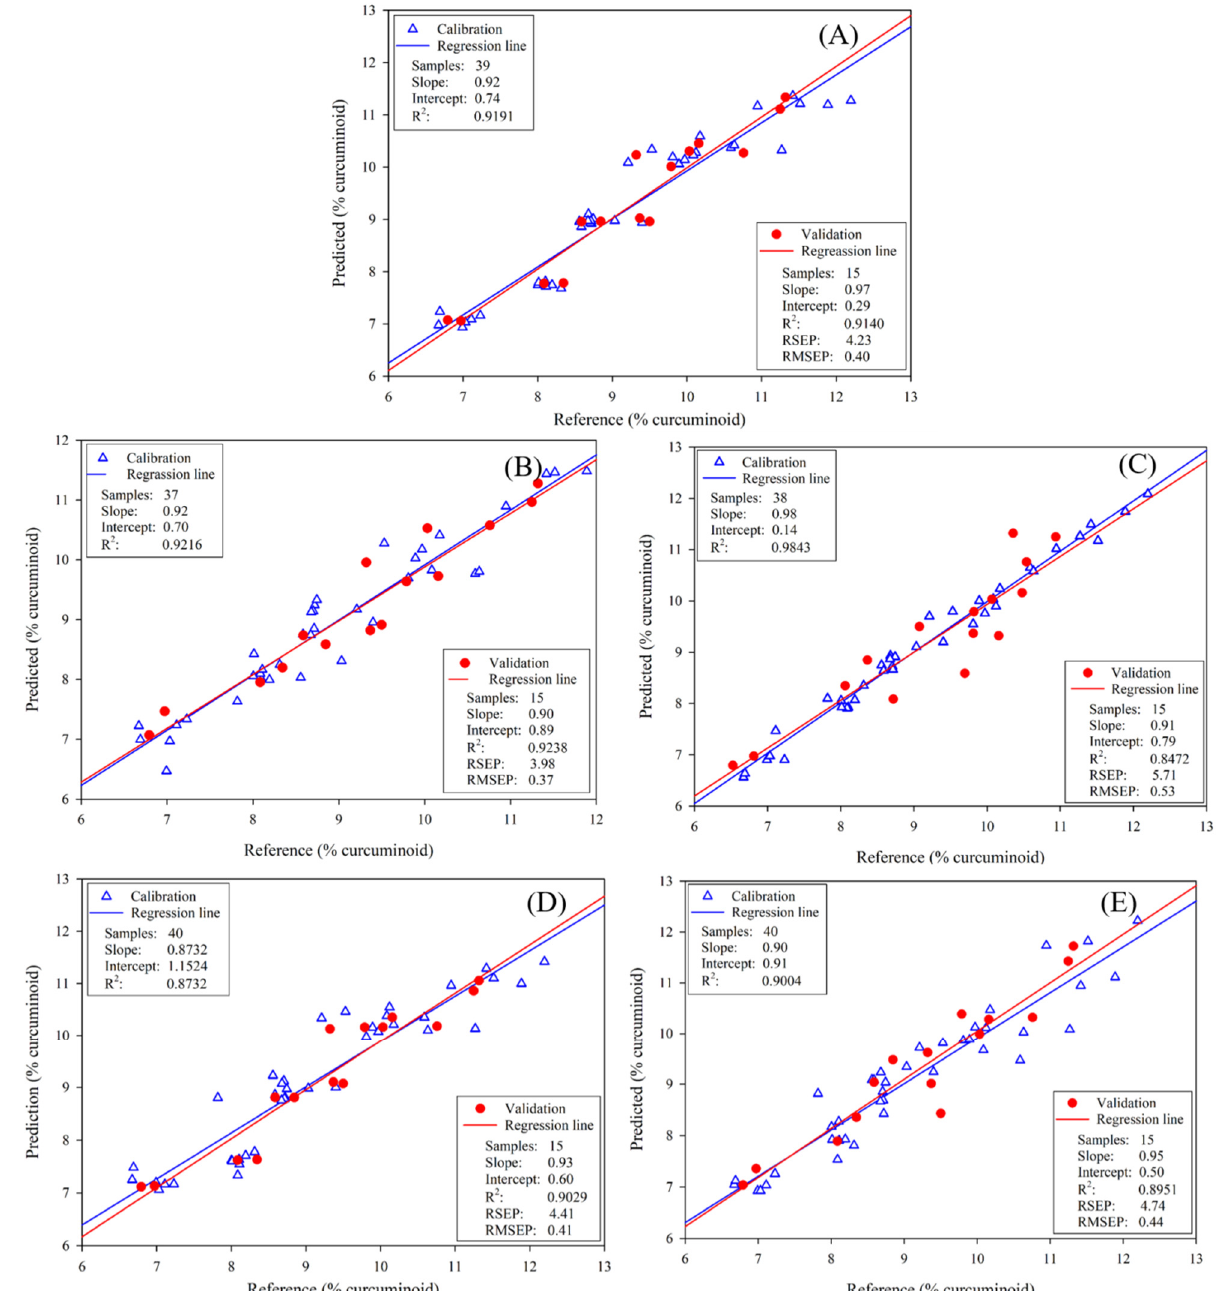
Figure 4. Calibration and validation curves of predicted curcuminoid values vs. reference obtained from the PLS model after the pre-processed data as described in Figure 3.